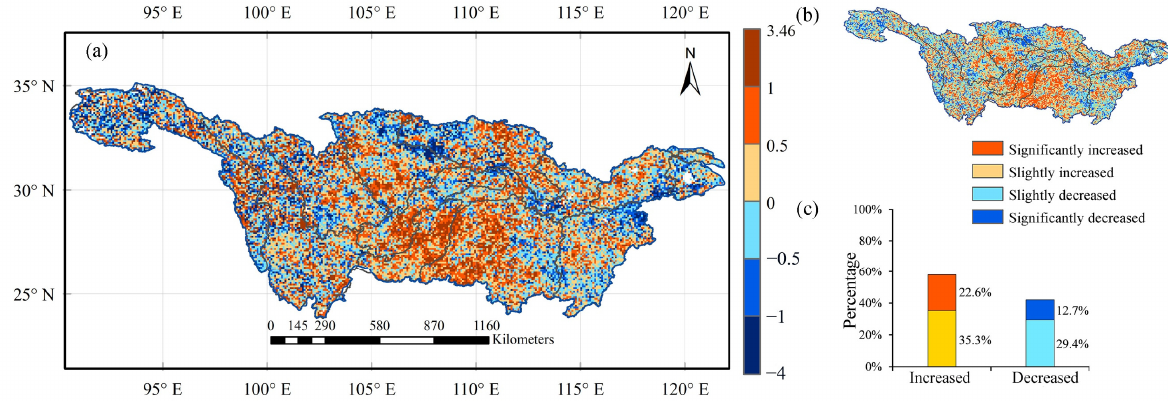
Figure 6. Spatial distributions of ( a ) trends, ( b ) trend types, and ( c ) the percentage of trend types in the VSI.